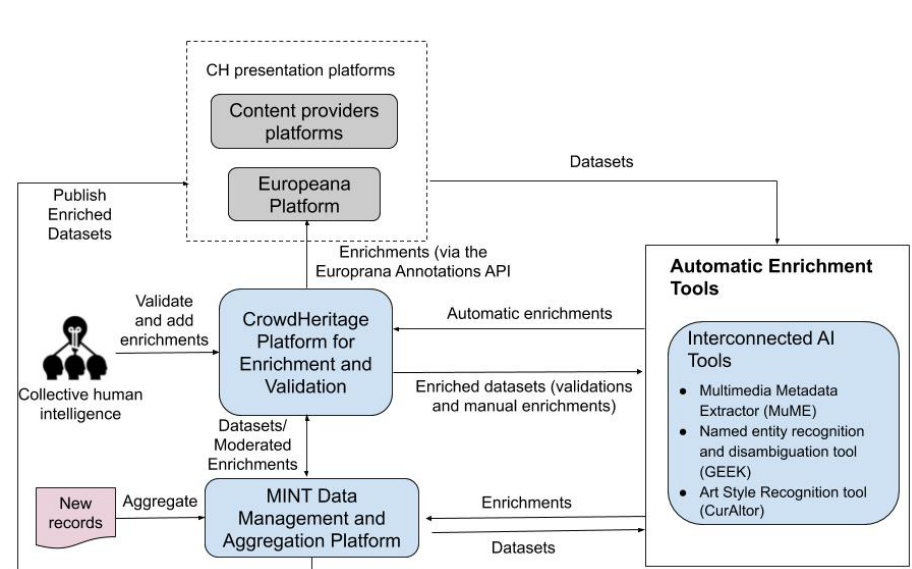
Figure 1. Architectural overview of the CrowdHeritage